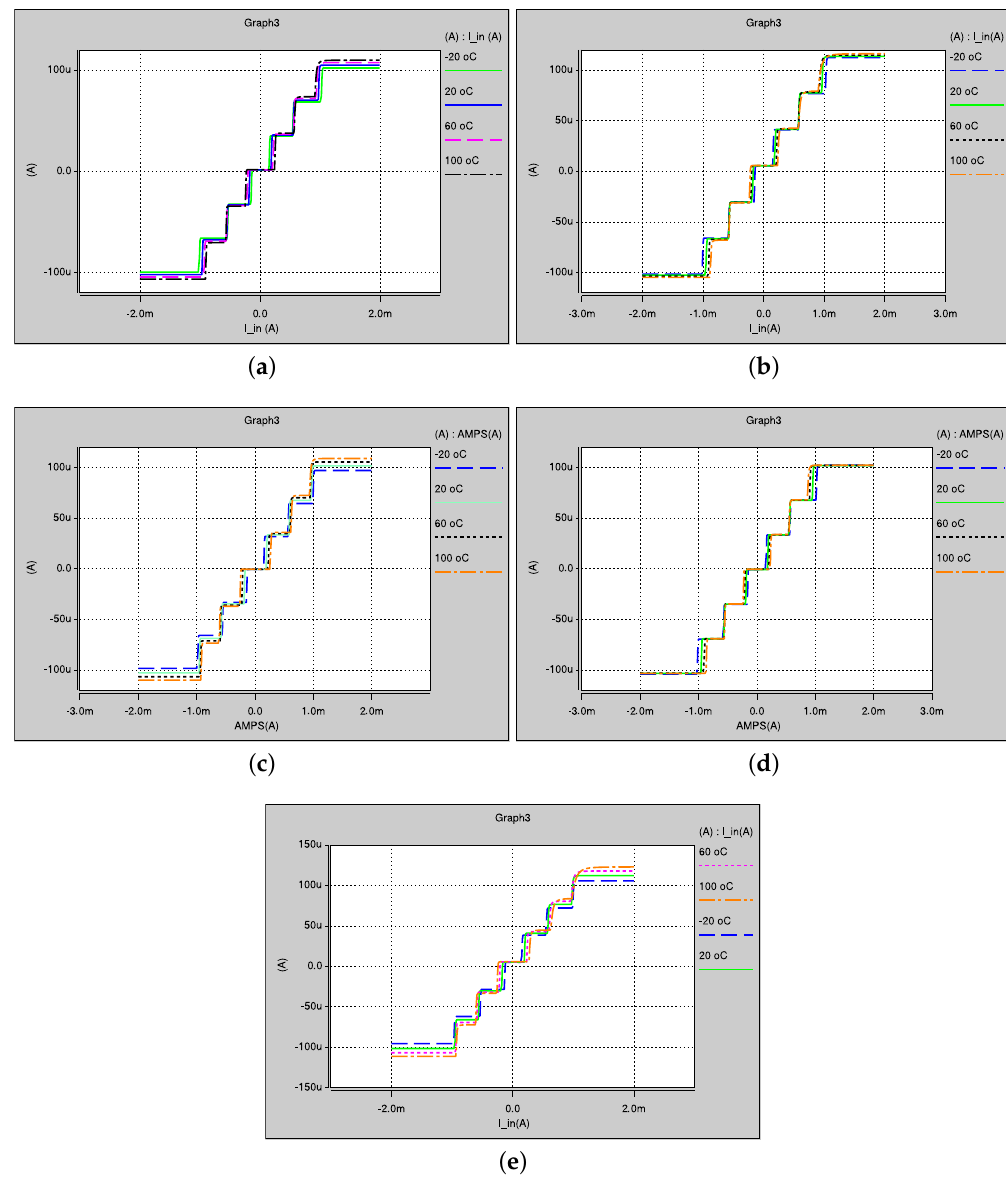
Figure 14. Temperature variations of the proposed PWL function in DC to generate seven-scroll: ( a ) TT; ( b ) SF; ( c ) FS; ( d ) SS; and ( e ) FF corner.